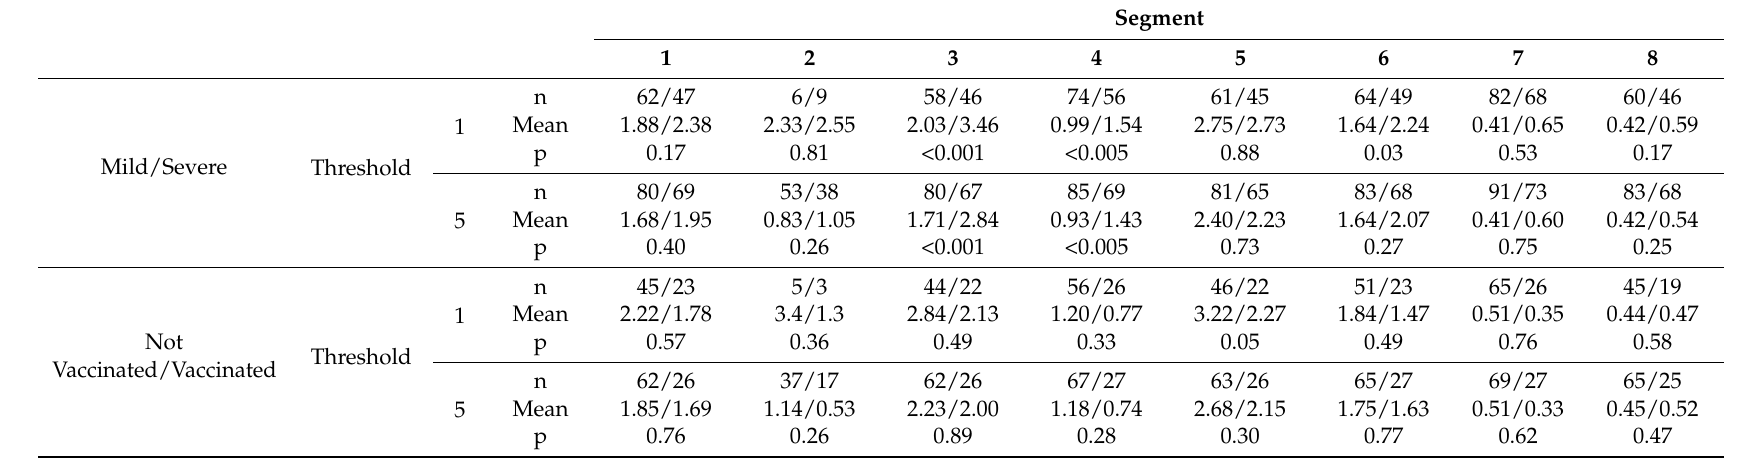
Table 3. Estimated mean quasispecies diversity comparison according to segment. Number of samples (n), mean diversity, and Mann Whitney Wilcoxon test p -value resulting from their comparison, when considering whether variants above 1% or 5% are reported in each